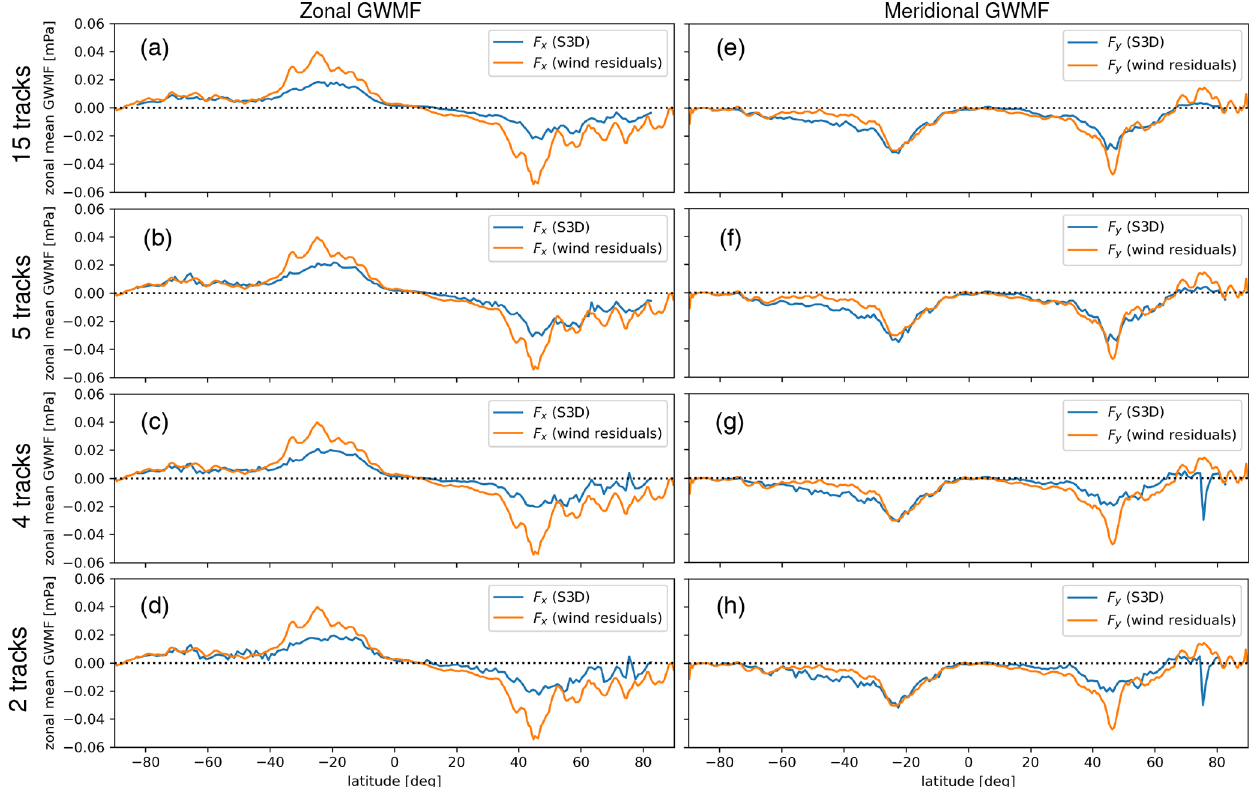
Figure 14. Line comparison plots of zonal (a–d) and meridional (e–h) zonal mean GW momentum flux calculations in 1 ◦ latitude bins from S3D analysis (blue line) and directly from wind fluctuations (orange line) for an altitude of 75km. It is in line with the four cases as in Fig. 10. GWMF from wind residuals is running-averaged over 5 ◦ latitude bins and vertically running-averaged over 5km altitudes.